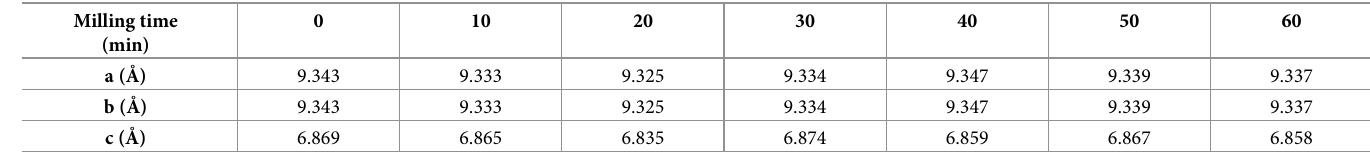
Table 4. Unit-cell parameters (a, b, c) of apatite present in the studied phosphorite subjected to mechanochemical treatment of various duration. Milling time